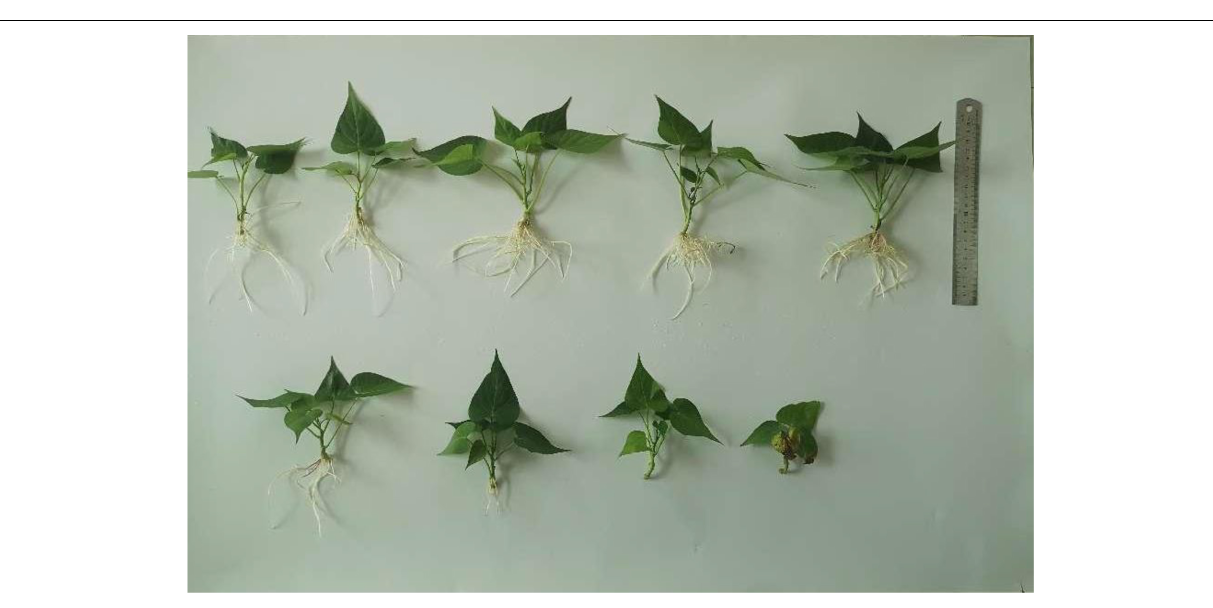
FIGURE 3 | Growth of 20167-6 under different selenium concentrations. The selenium concentrations in the first row from left to right are 0, 0.2, 0.5, 1, and 3 mg/L, and the selenium concentrations in the second row from left to right are 5, 10, 20, and 40